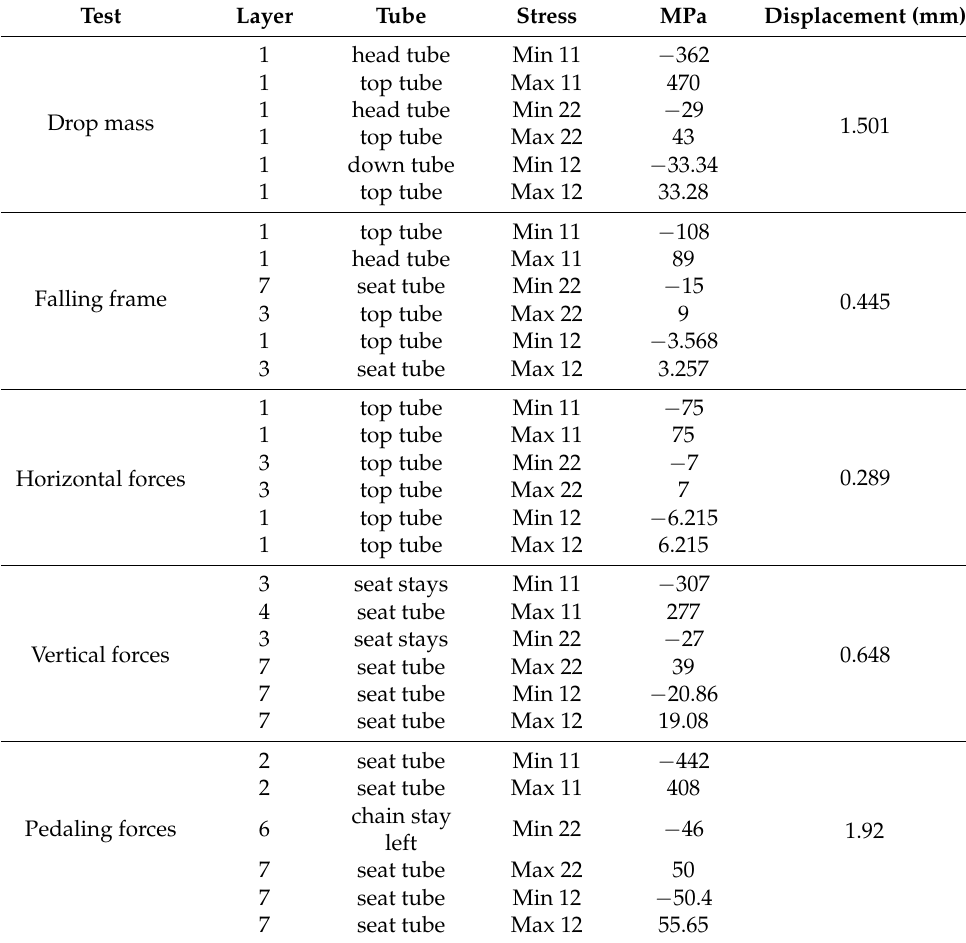
Table 28. Stress and displacement results of stacking scenario 10.